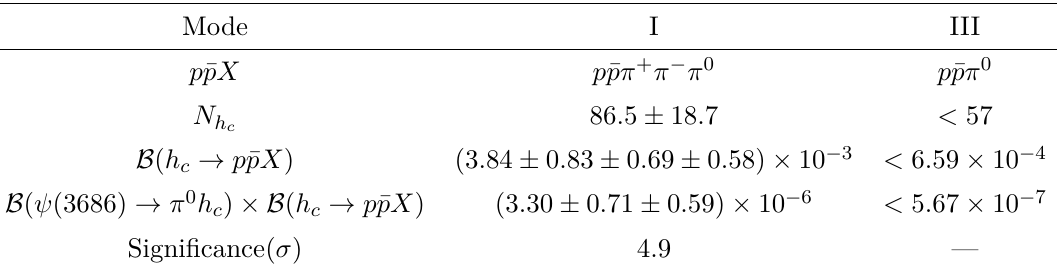
— , the absolute branching fraction B ( h ¯ pX ) , c → p c ) × B ( h ¯ pX ) , and the statistical significance, c c → p [19]. c